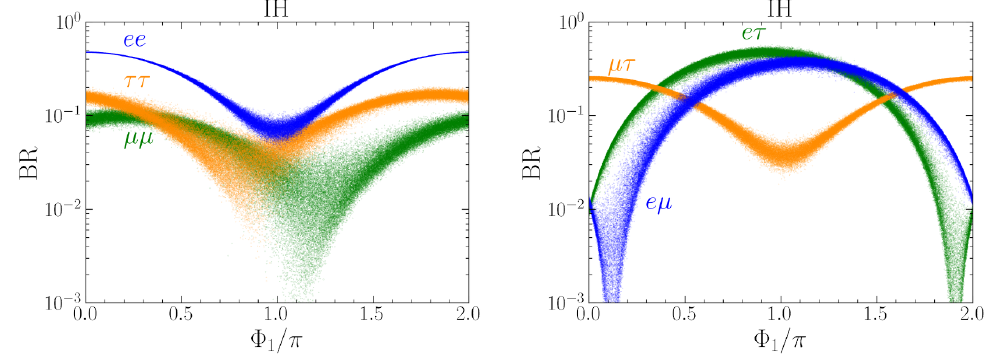
Figure 4 . Scatter plots for the same flavor (left) and different flavor (right) leptonic branching ratios for the H ++ decay versus Majorana phase Φ Majorana phase Φ is uniformly sampled within [0 , 2 π ) 1